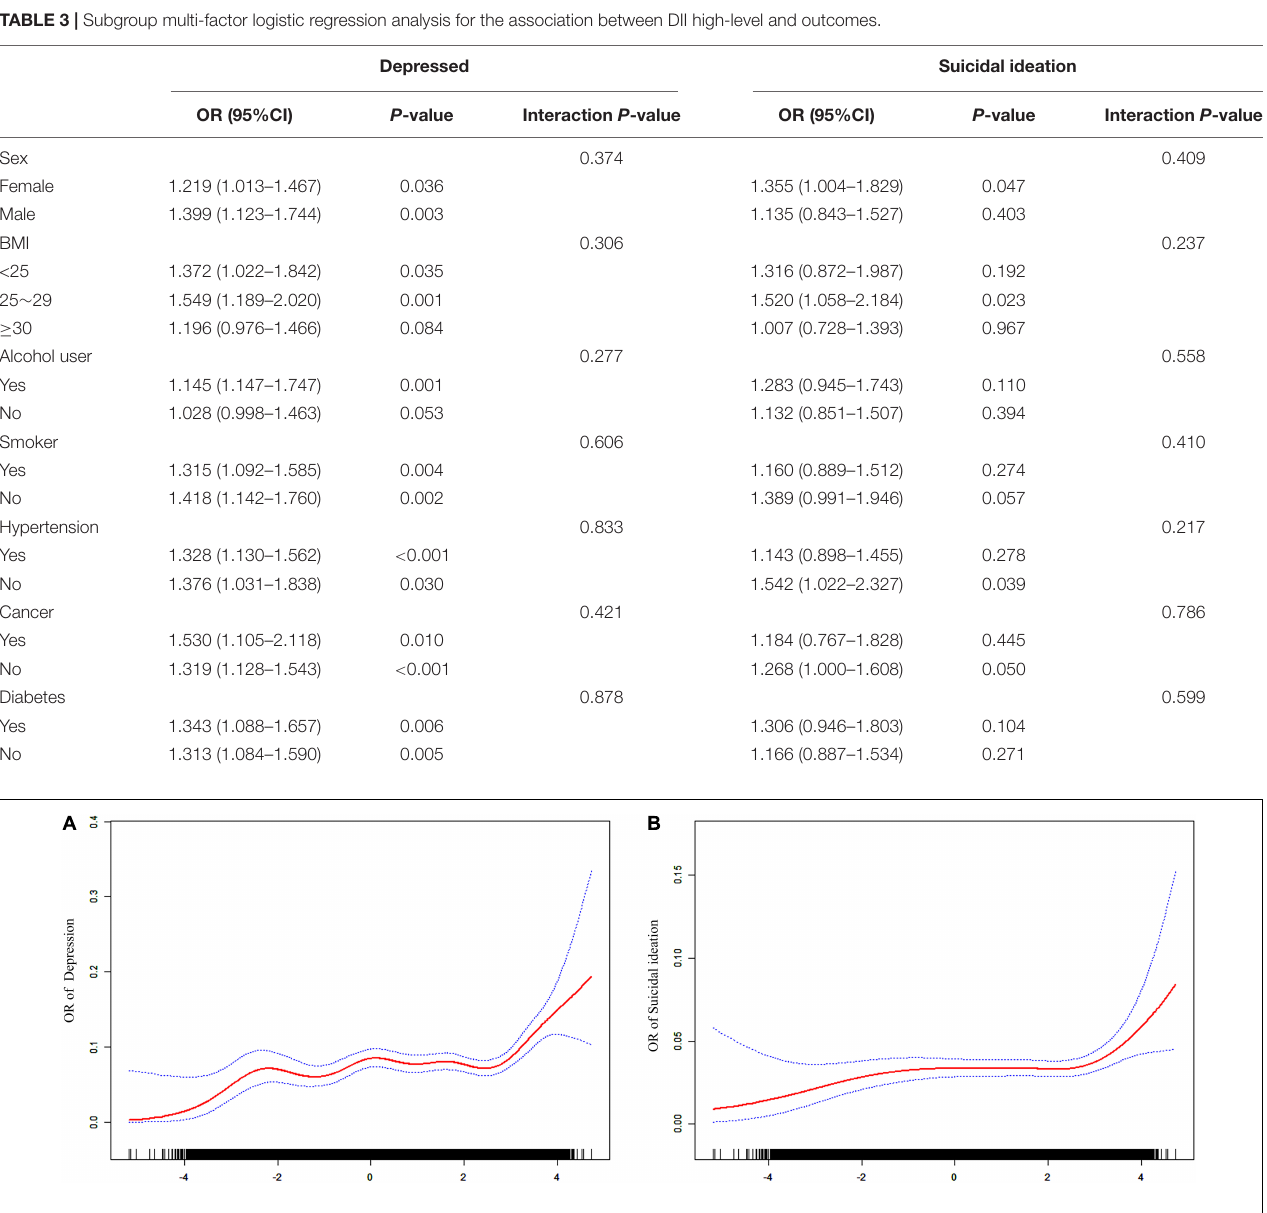
FIGURE 2 | Dose-response association between (A,B) OR of depression and suicidal ideation and DII (adjusted for age, sex, race, smoker, alcohol user, glucocorticoid user, hypertension, cancer, and diabetes).